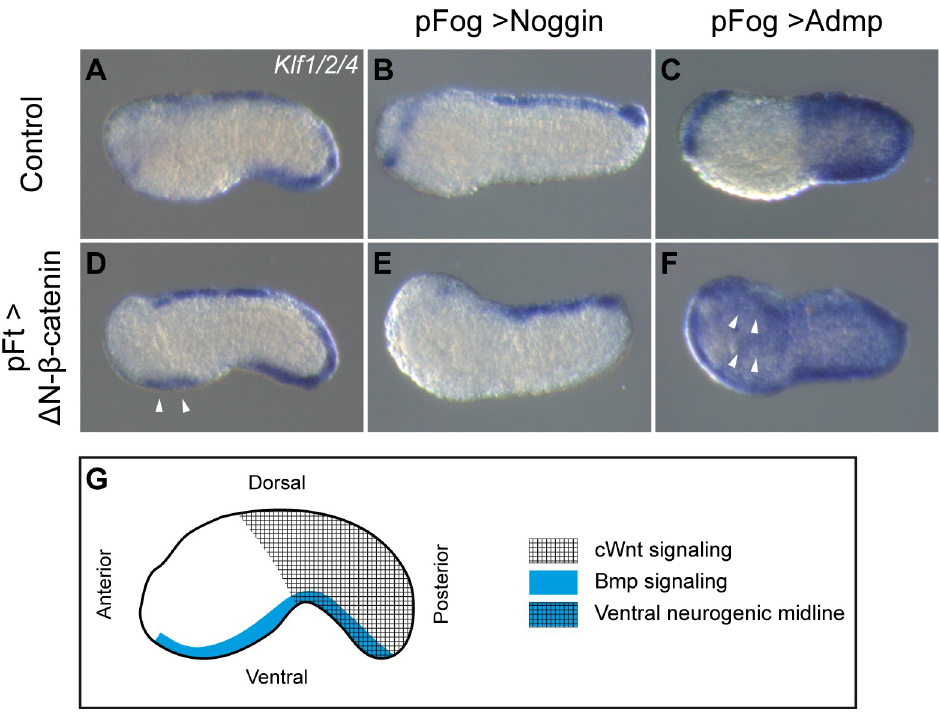
Fig 4. A combination of Bmp and Wnt signals defines the tail ventral neurogenic midline. (A) Control unelectroporated embryo. Embryos were electroporated with pFog > Noggin (B), pFog > Admp (C), pFt > Δ N- β -catenin (D), pFog > Noggin + pFt > Δ N- β -catenin (E), and pFog > Admp + pFt > Δ N- β -catenin (F), and fixed for in situ hybridization at initial tailbud stages (stage 18) for Klf1/2/4 . Ectopic staining is highlighted by the white arrowheads. (G) Schematic proposing that the tail ventral neurogenic midline territory forms where both Wnt and Bmp pathways are active. One experiment was performed.